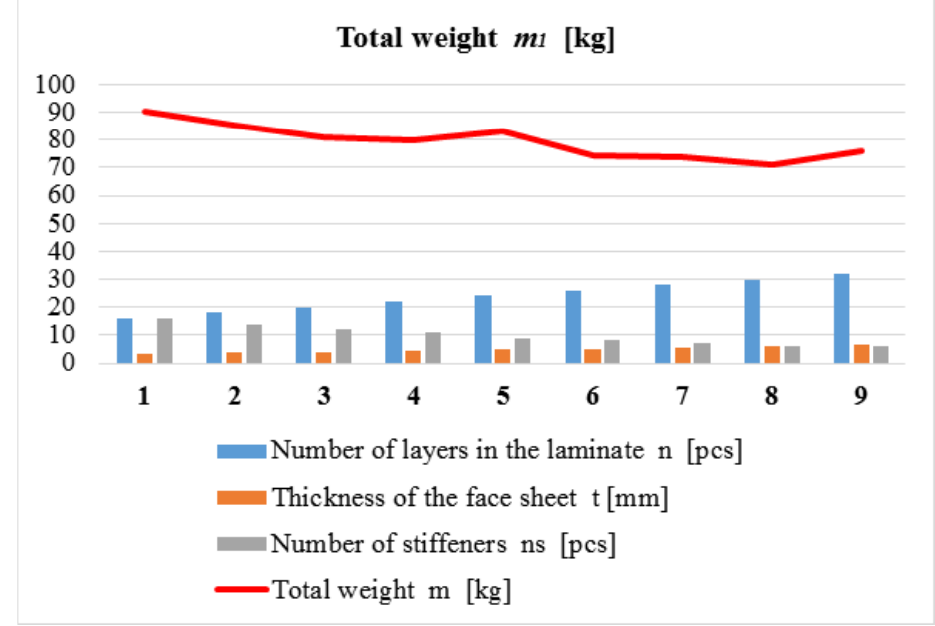
Figure 3. Result of the weight optimization.